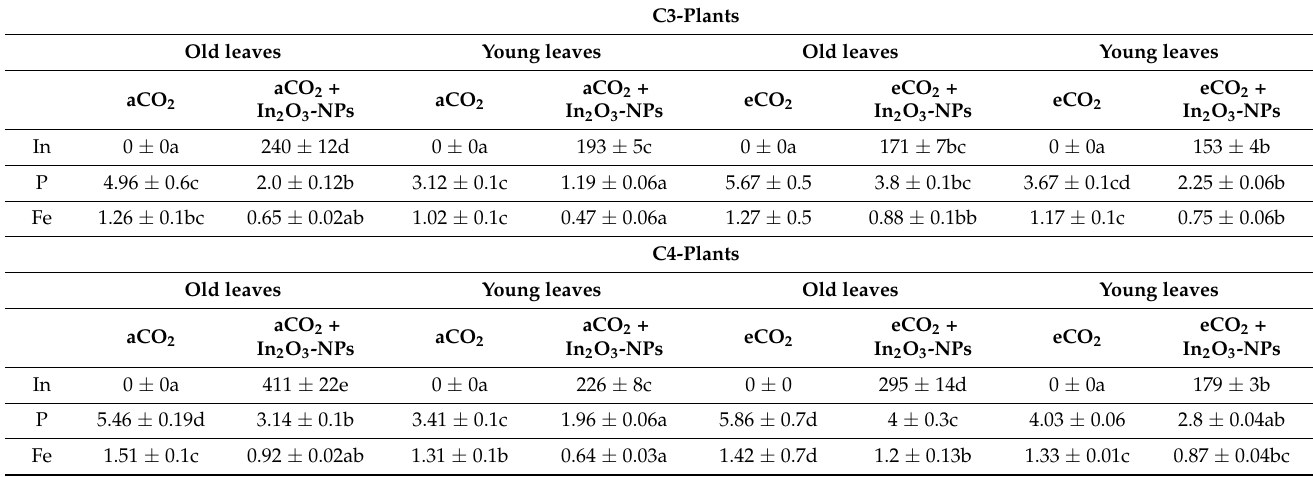
Table 1. Effect of indium oxide nanoparticles and/or elevated CO 2 (eCO 2 ) on the accumulation of Indium (In), Fe, and phosphorus (P) in old and young leaves of C3 and C4 plants. Four biological replicates are used to demonstrate each value ± SE. Fisher’s LSD test ( p < 0.05; n = 4) was used to compare the data for each response separately. Different letters indicate significant differences between means in young and old leaves of C3 or C4